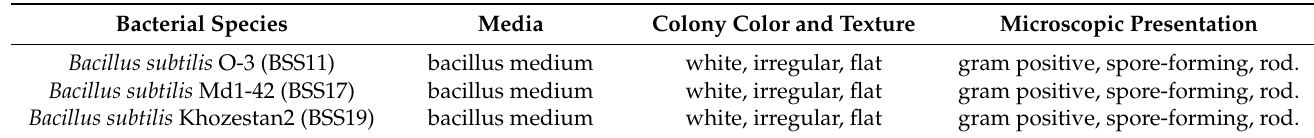
Table 1. Colony morphology and microscopic presentation of the isolated bacterial species.